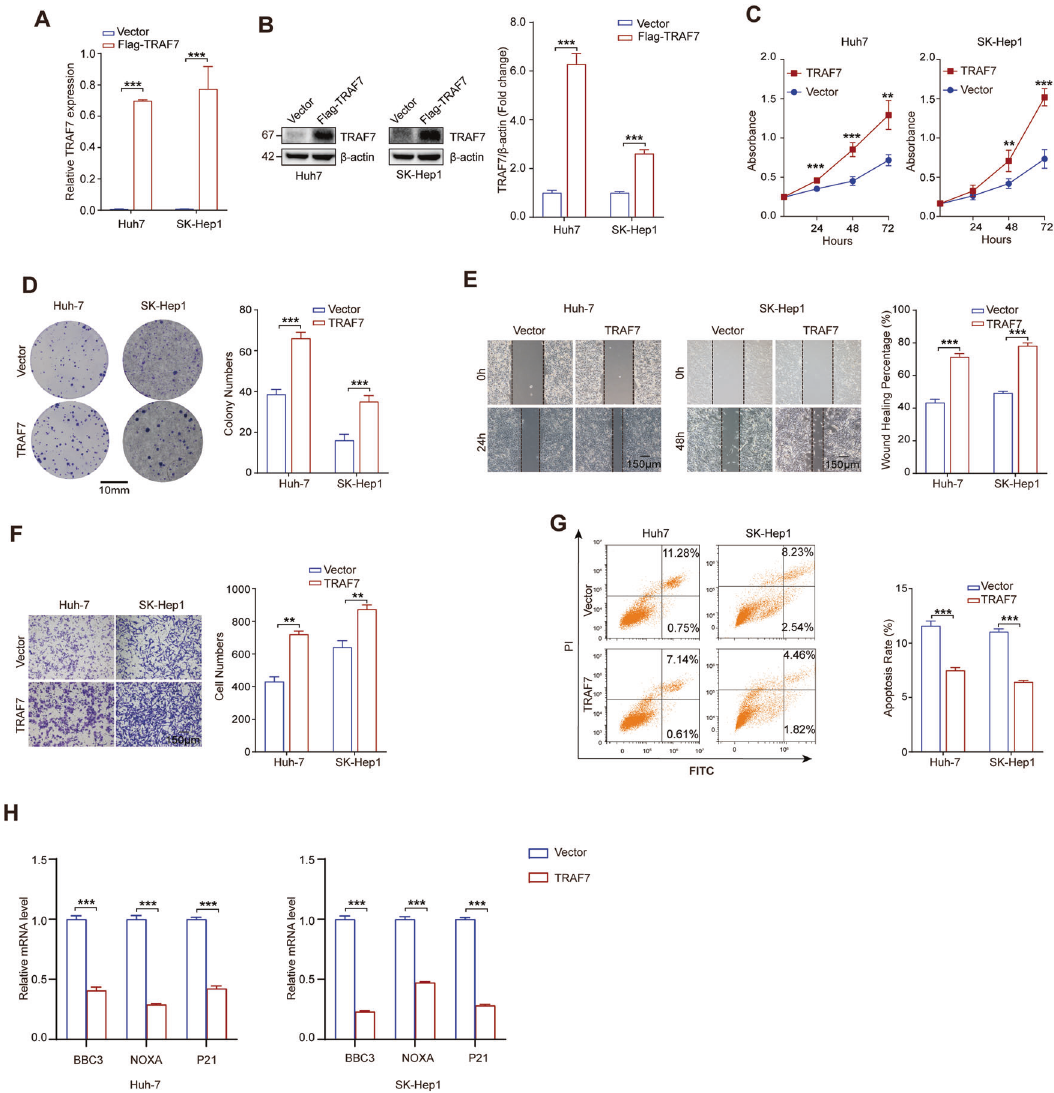
Fig. 2 TRAF7 overexpression promoted hepatoma cells growth, proliferation, migration, invasion and repressed apoptosis. A , B qRT-PCR and Western Blot analysis identi fi ed TRAF7 plasmid transfection ef fi ciency in Huh-7 and SK-Hep1 cells. C , D Cell Counting Kit-8 analyses and Colony formation indicated that TRAF7 facilitated hepatoma cells proliferation in Huh-7 and SK-Hep1 cells. E , F Wound-healing and transwell analyses showed enhanced migration and invasion abilities in TRAF7 overexpressed Huh-7 and SK-Hep1 cells. G Flow cytometry exhibited that TRAF7 inhibited cell apoptosis in Huh-7 and SK-Hep1 cell lines. H qRT-PCR detecting pro-apoptotic effector genes (BBC3, NOXA) and cell cycle arresting gene P21 in TRAF7 overexpressed Huh-7 and SK-Hep1 cells. All experiments were performed in triplicate. ** p < 0.01; *** p <